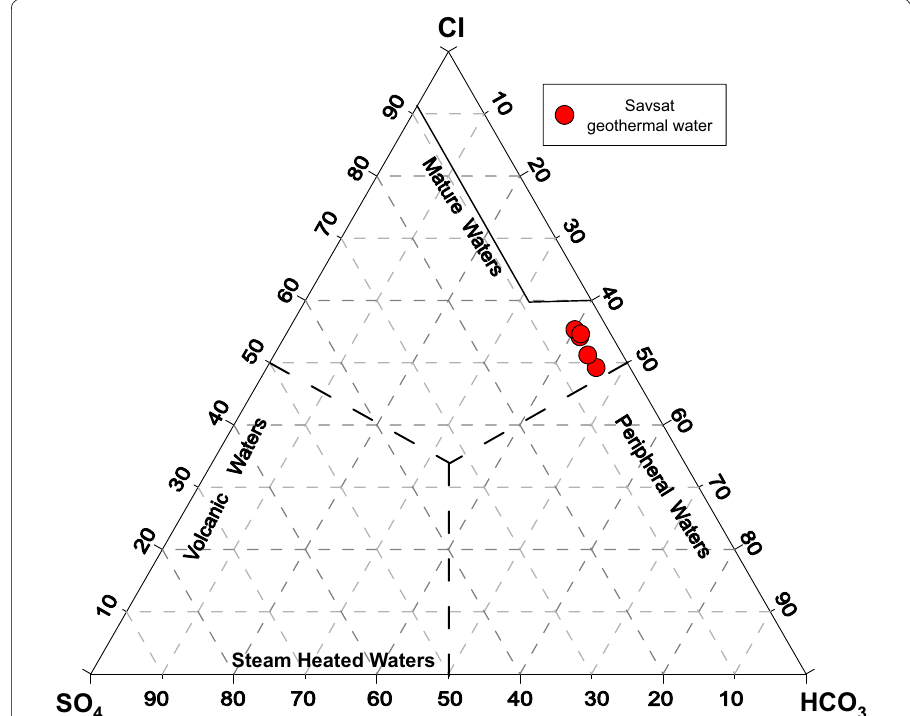
Fig. 11 Cl–SO 4 –HCO 3 ternary diagram for geothermal waters